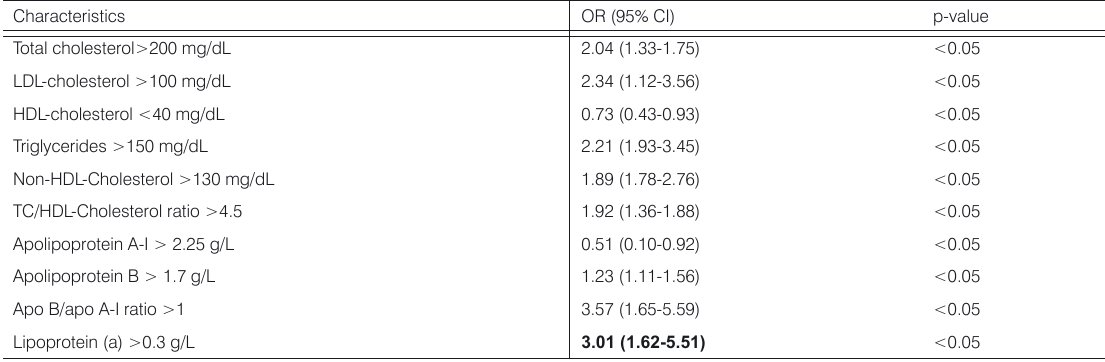
Table 3. Risk for future coronary artery disease, by lipid and apolipoproteins levels .